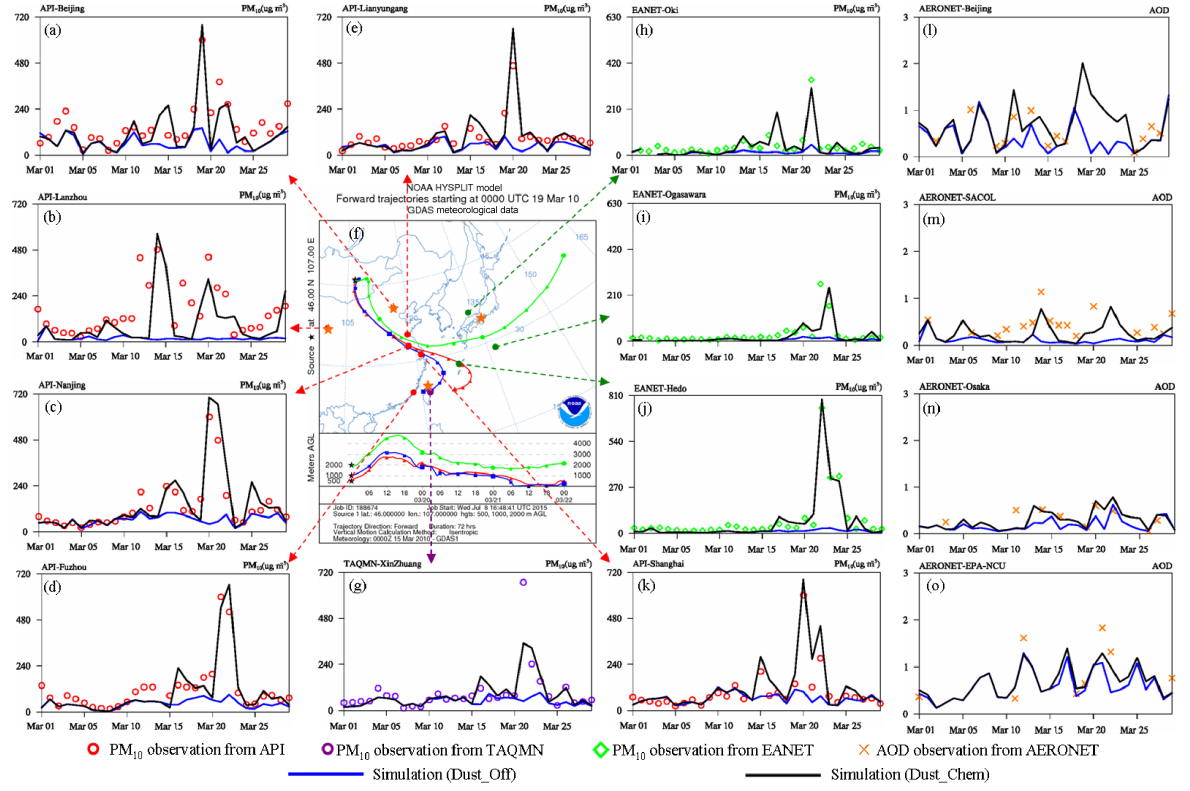
Figure 8. Forward trajectories from (f) HYSPLIT and temporal variations of PM 10 and AOD on a daily scale. Comparison between simu- lated (black lines for Dust_Chem scenario and blue lines for Dust_Off scenario) and observed PM 10 from API (red circles) at (a) Beijing, (b) Lanzhou, (c) Nanjing, (d) Xiamen, (e) Lianyungang, and (k) Shanghai. Comparison between simulations and observed PM 10 from TAQMN (purple circles) at (g) Xinzhuang. Comparison between simulations and observed AOD from EANET (green diamonds) at (l) Bei- jing, (m) Semi-Arid Climate Observatory Laboratory (SACOL), (n) Osaka, and (o) National Central University (NCU). Locations of cities or stations are indicated by the starting point of the arrows (for PM 10 ) or orange stars (for AOD)